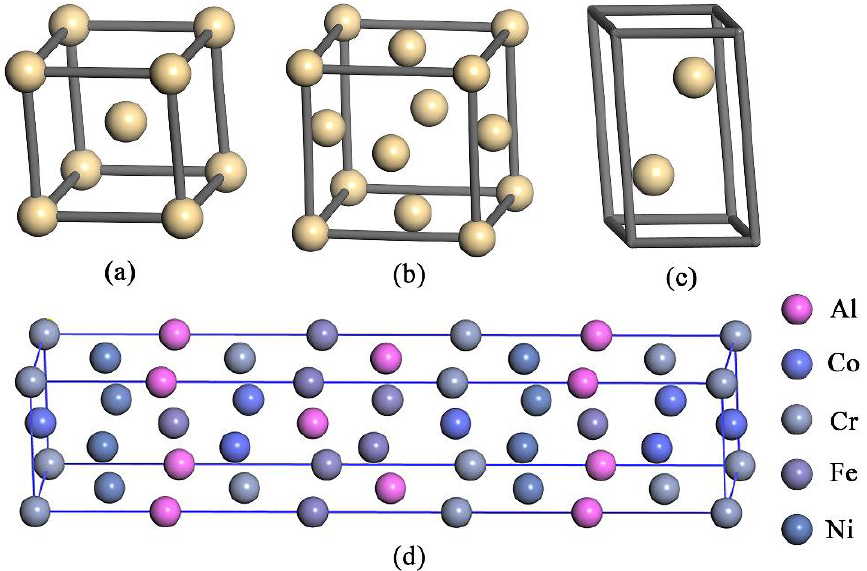
Figure 1. The AlCo x CrFeNi HEAs model constructed by VCA: ( a ) BCC phase, ( b ) FCC phase and ( c ) HCP phase. The model of AlCoCrFeNi HEA constructed by SQS: ( d ) FCC